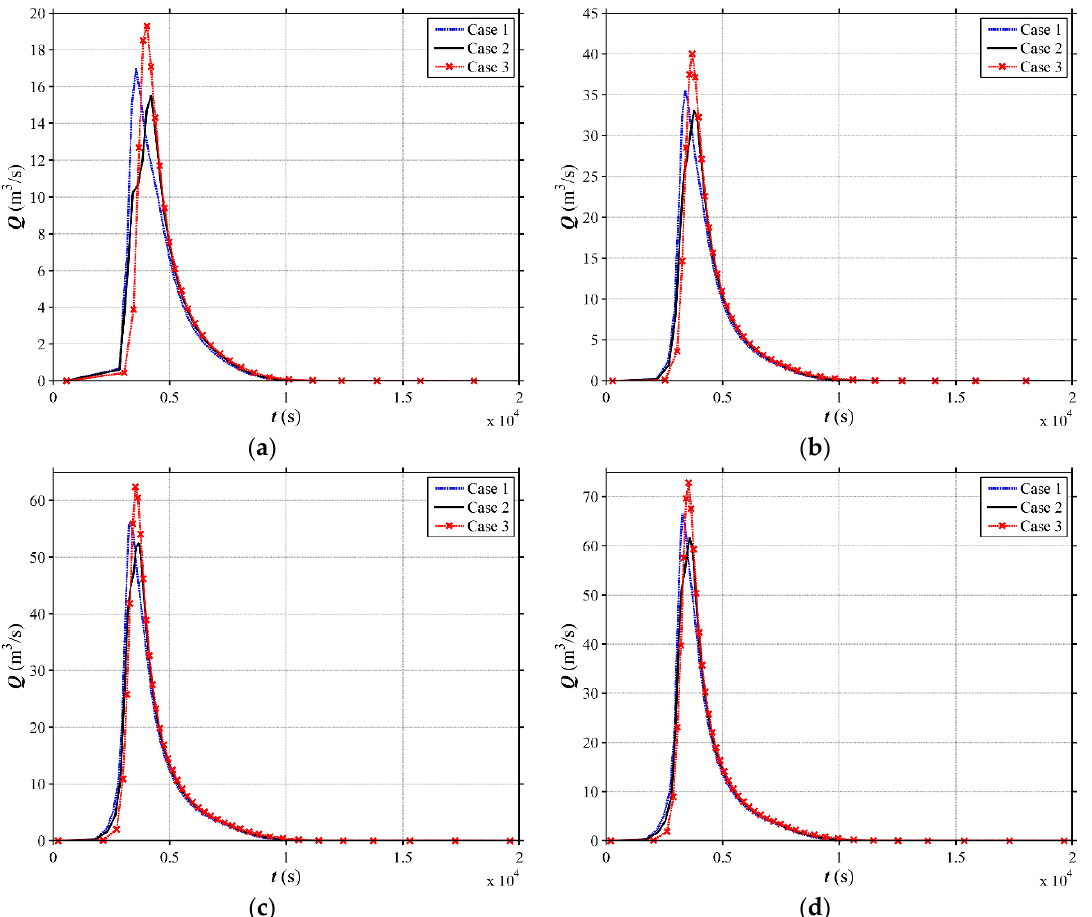
Figure 6. Simulated hydrographs at the outlet for different land use scenarios in the V-shaped catchment with i 1 = 0.02. ( a ) 2-year; ( b ) 10-year; ( c ) 50-year; ( d ) 100-year.